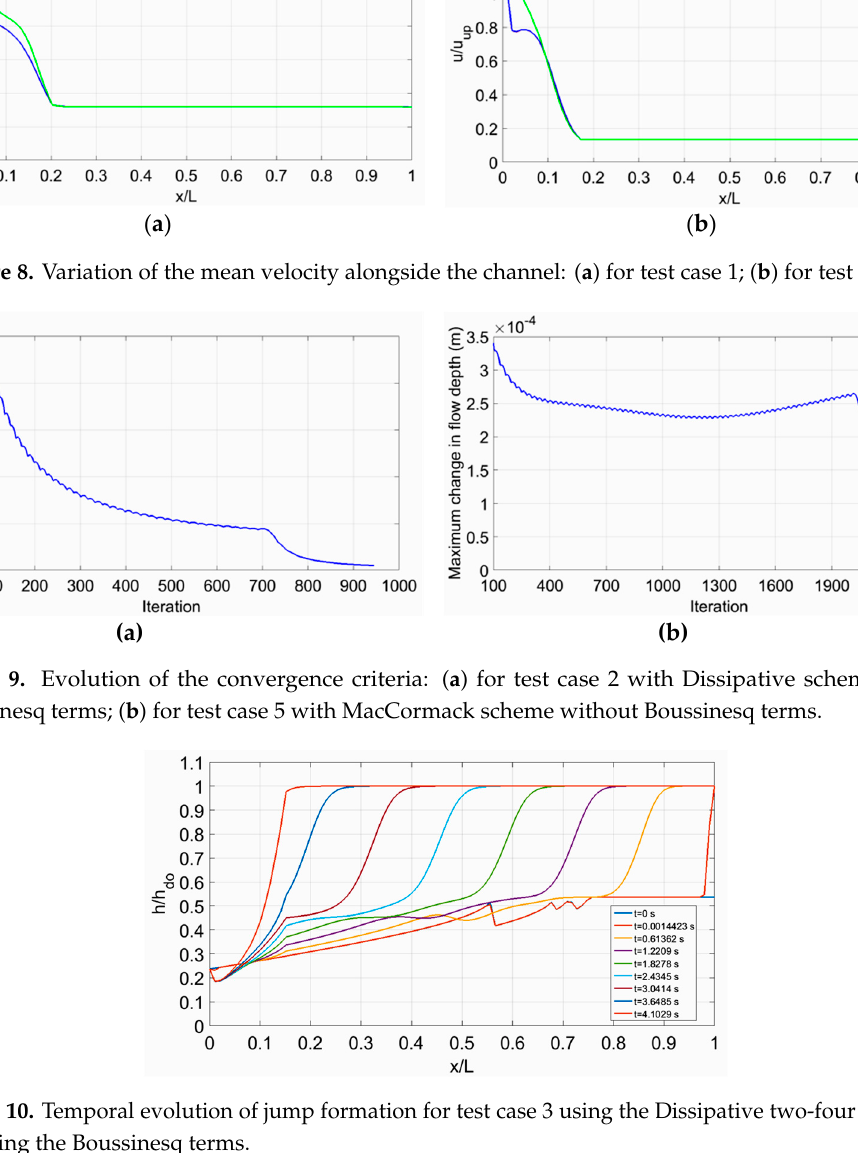
Figure 11. Temporal evolution of jump formation for test case 4 using the Dissipative two-four scheme including the Boussinesq terms.